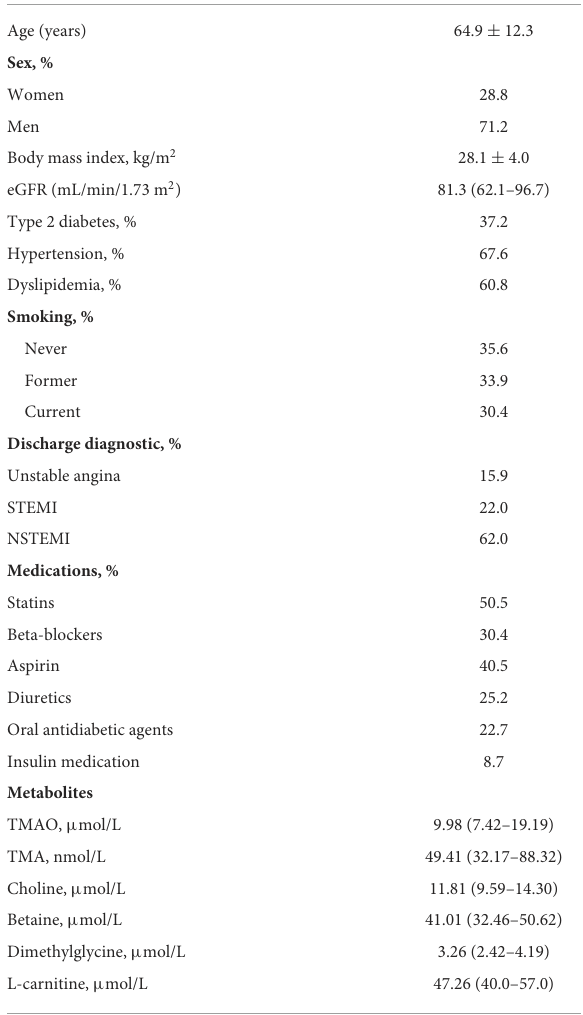
TABLE 1 Baseline characteristics of